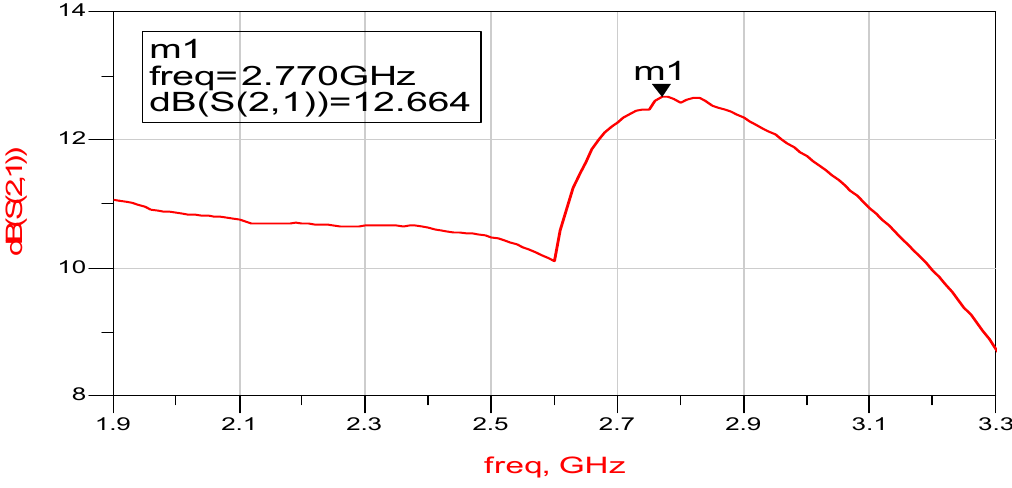
Figure 14. S21 of an Active Transmitting Circular Receiving Patch antenna. Table 3. High-power amplifier (HPA) specification at S band.